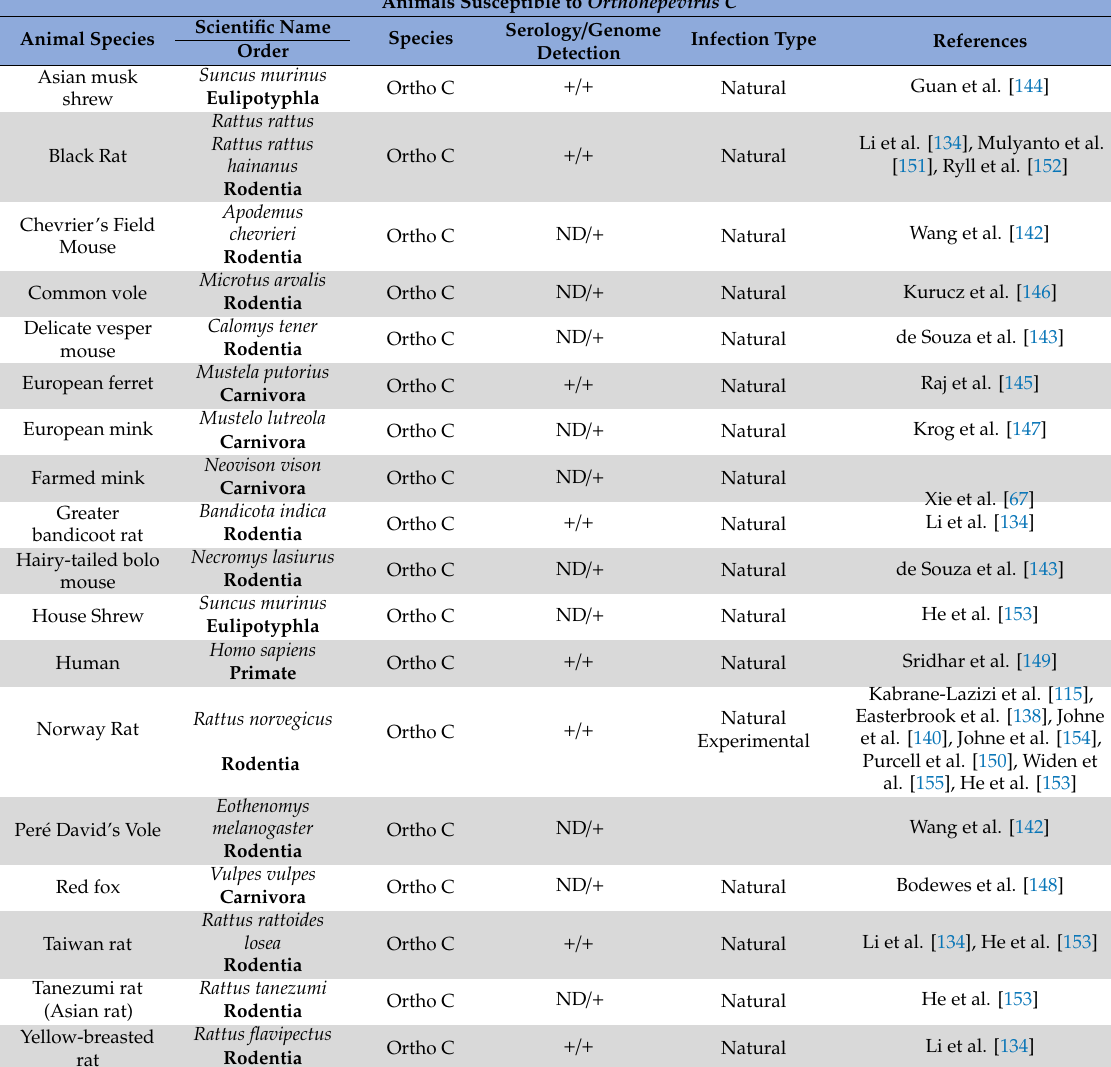
Table 3 Species reported to be infected with Orthohepevirus C strains of HEV. Names in bold represent taxonomic order. Under serology / genome detection “ + ” indicates any positive report for that assay within the literature, “-“ represents the test being performed with negative results, ND indicates the test was not performed (Not Done). a Serology / Genome Detection summarizes findings from all literature, some article may have only shown serology positive, genome positive, or